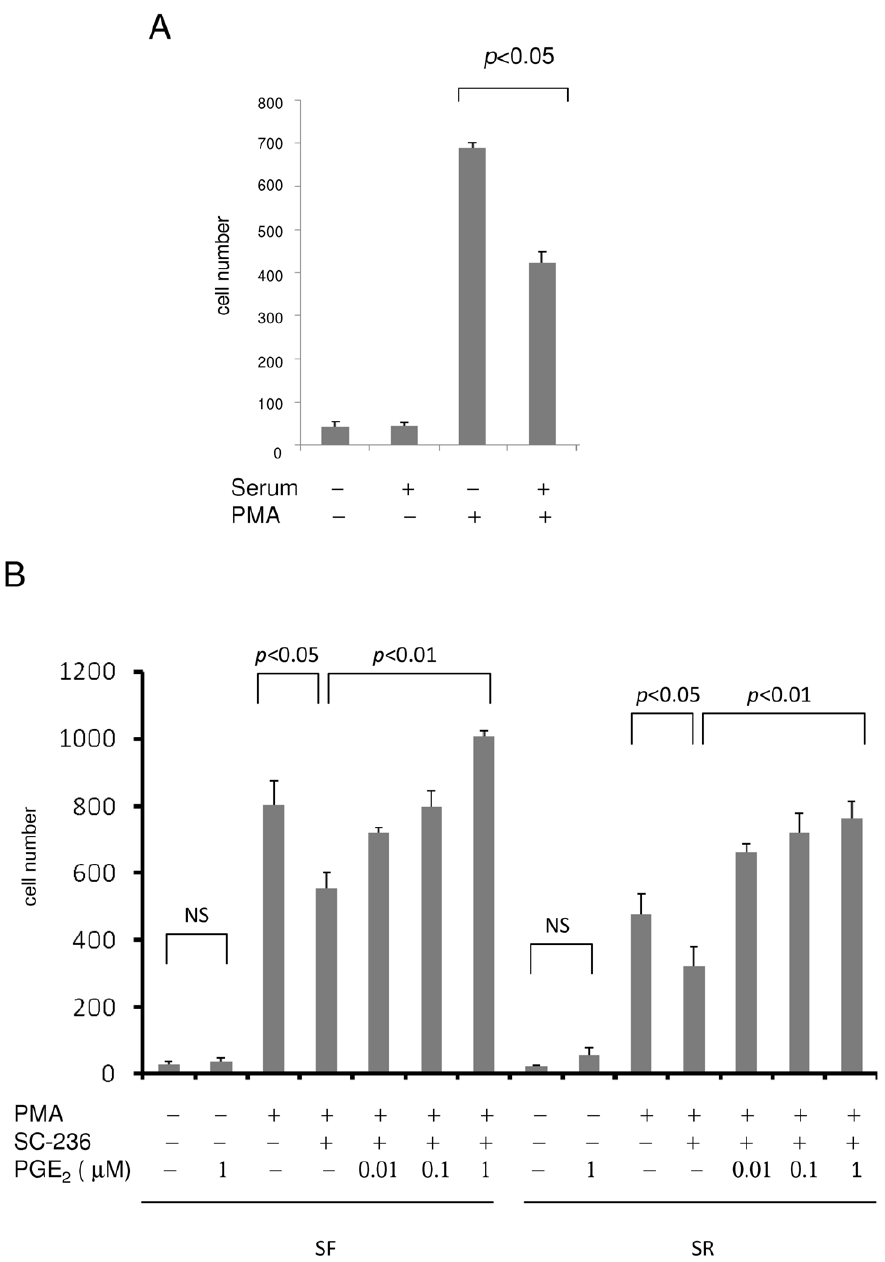
Figure 10. Migration of SF- vs. SR-HsFb. ( A ) SF- or SR-HsFb were treated with PMA for 6 h and cells migrated to the under surface were counted. ( B ) SF-HsFb or SR-HsFb were treated with SC236 (1 uM) for 30 min followed by PMA for 4 h. Cells were applied to the transwell migration assay. For the PGE 2 rescue experiments, PGE 2 was added together with SC236 before stimulation with PMA. Error bars refer to mean 6 SEM (n=3).